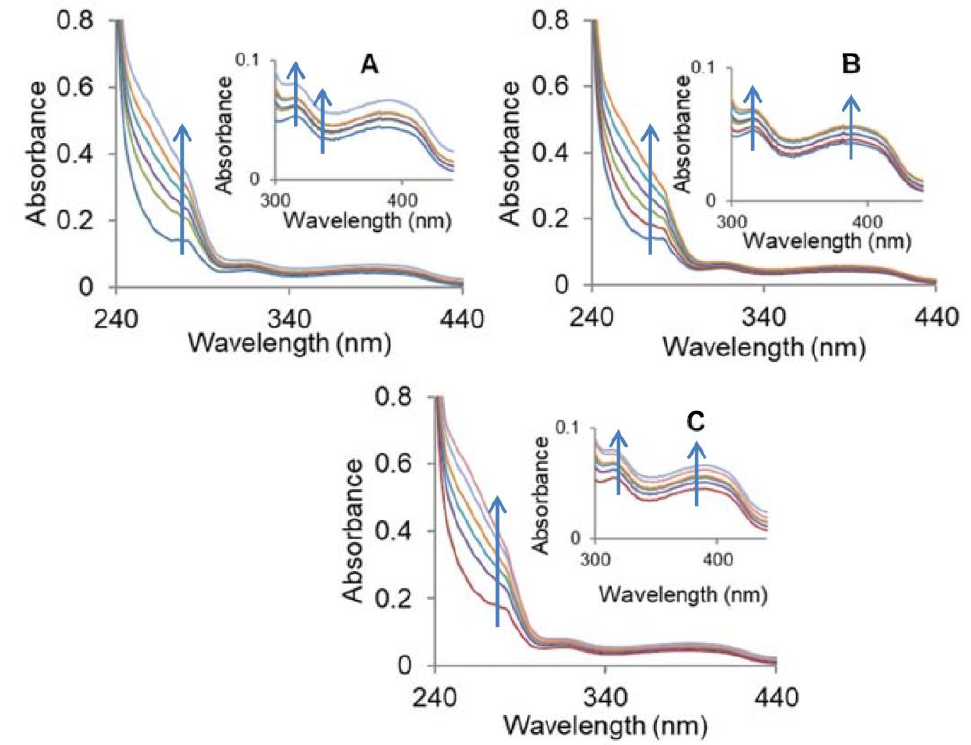
Figure 3. Absorption spectra of complexes ( A ) 1 , ( B ) 2 , and ( C ) 3 , with calf thymus-DNA (CT-DNA) in 5 mM Tris-HCl/50 mM NaCl buffer of pH 7.5 at room temperature.